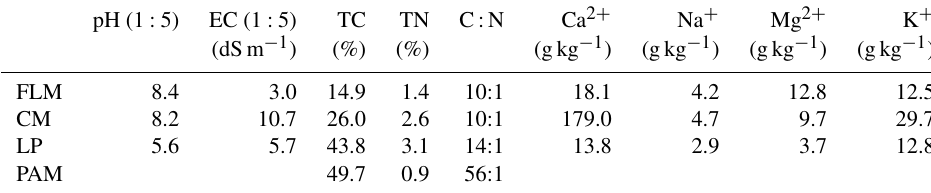
Table 2. Chemical properties of organic amendments.